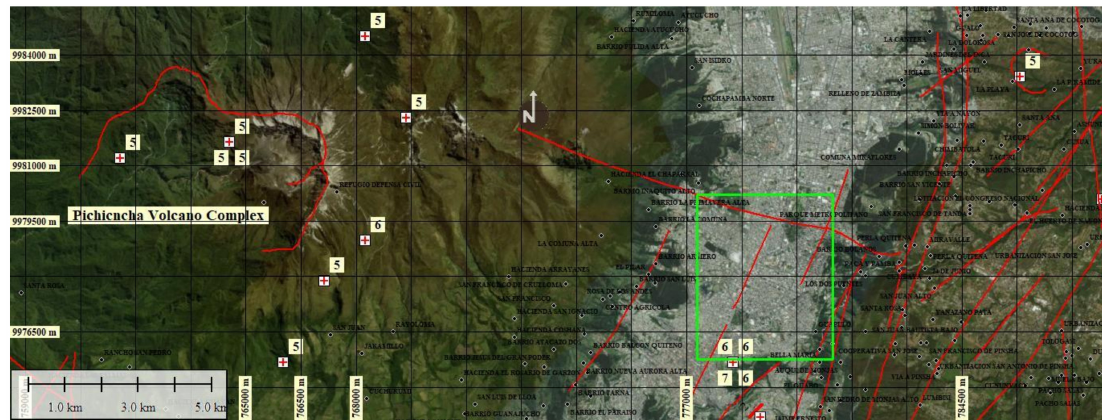
Figure 2. Location of La Mariscal in the Quito city (green polygon). Geological faults (red lines) and earthquake epicenters (red crosses). Base image source: Esri, DigitalGlobe, Google https: // services.arcgisonline.com / ArcGIS / rest / services / World_Imagery / MapServer. 2.1. Phase 1: Interferometry of Synthetic Aperture Radar. Brief Summary of the Atmospheric Phase